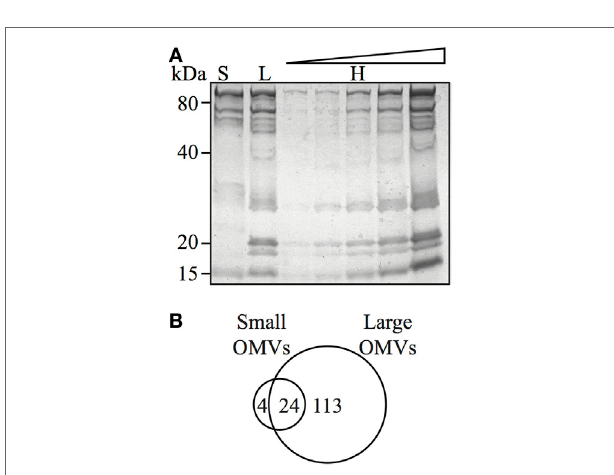
FigUre 3 | Outer membrane vesicle (OMV) size determines their route of entry into epithelial cells. The average signal density of internalized small (a) or large (B) green fluorescent (OMVs) into AGS cells pre-treated with siRNAs to specifically inhibit clathrin (CTLC), caveolin (CAV), dynamin (DYN), or macropinocytosis (PAK) was measured and normalized to OMV alone group treated with control siRNA. Data are pooled from three-independent experiments in which > 100 AGS cells were counted per treatment. Error bars indicate ± SEM of > 100 cells. *** P < 0.001, **** P <